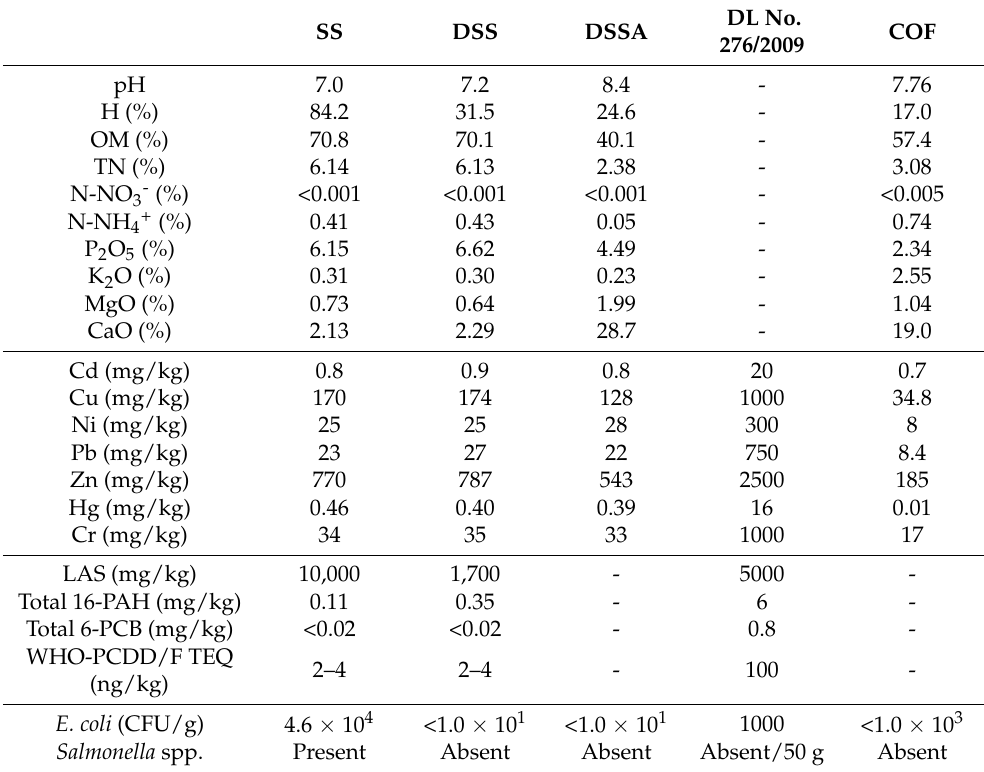
Table 3. Physicochemical and microbiological characteristics of the sewage sludge-based products and commercial fertilizer, with respective legal